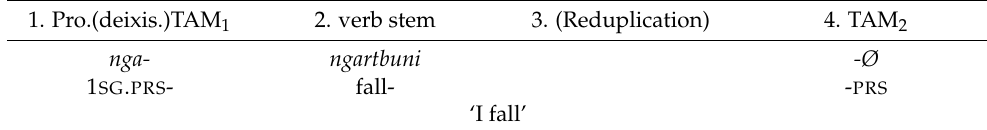
Table 1. The Iwaidja verb